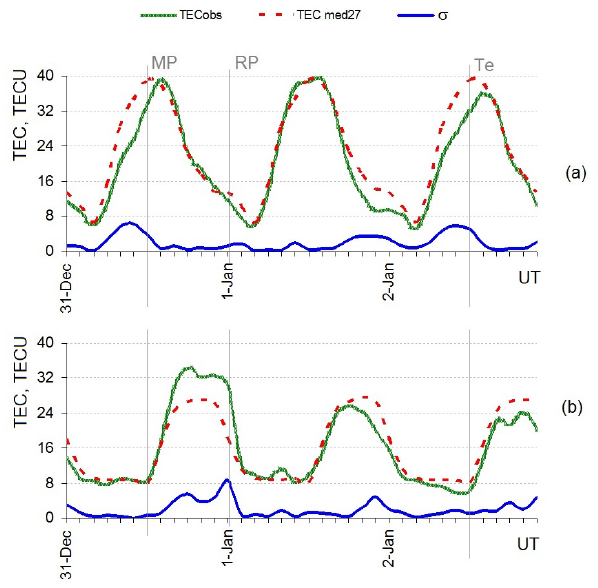
Figure 3. Results for storm no. 3 at latitude 20 ◦ N: for Euro- African (a) and American meridians (b) . Observed TEC (green curve), 27-day running median (red dotted curve) and standard de- viation σ of the observed TEC (blue curve). MP, RP and Te are marked by vertical